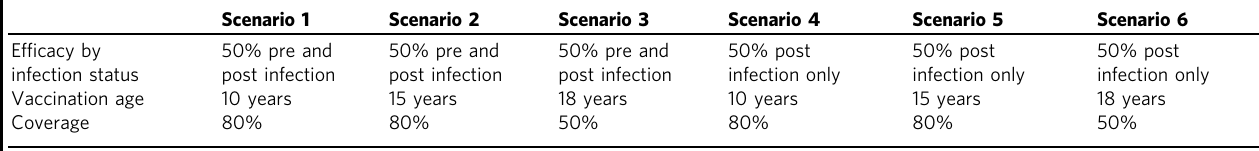
Table 2 Characteristics of modelled M72/AS01 E -like